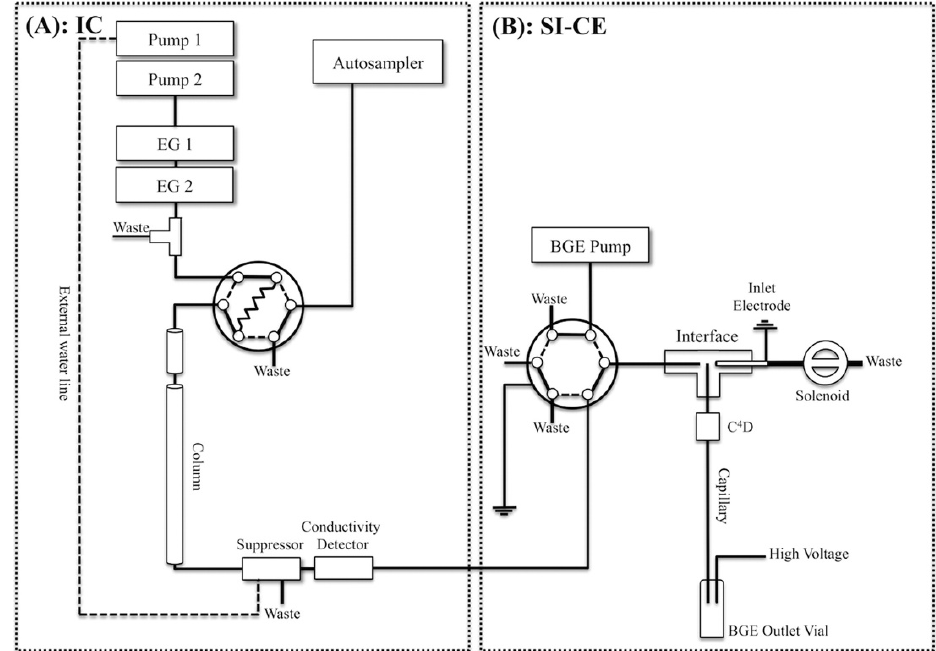
Figure 3. Schematic diagram of a two-dimensional ion chromatography (IC) ( A ) and sequential injection (SI)-capillary electrophoresis (CE) system with conductivity detections developed for the determination of inorganic anions and organic acids in waters ( B ) [79]. (Reproduced under permission from ACS, licence is not required).